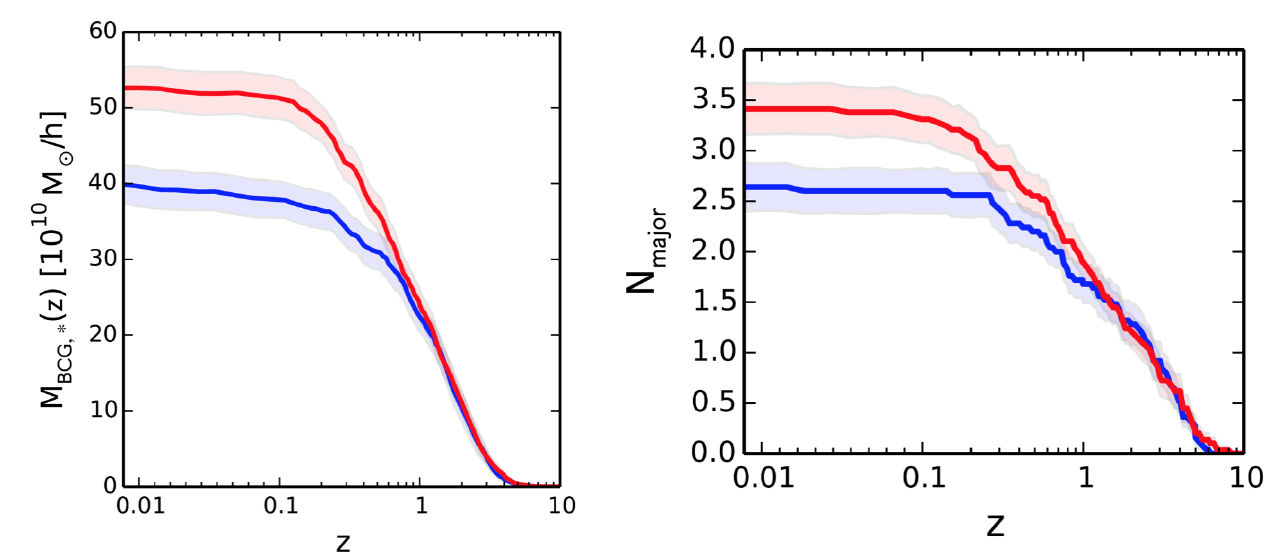
Figure 3. Left panel : average stellar mass assembly history for central galaxies within r 200 . Shaded areas are 1 σ errors calculated from 1000 bootstrap resamplings. Right panel : average number of cumulative major mergers occurred at the central galaxy across z. In both panels, fossil and non-fossil systems are represented in red and blue, respectively. The image is taken from Kundert et al. [34], in particular from their Figures 6 and